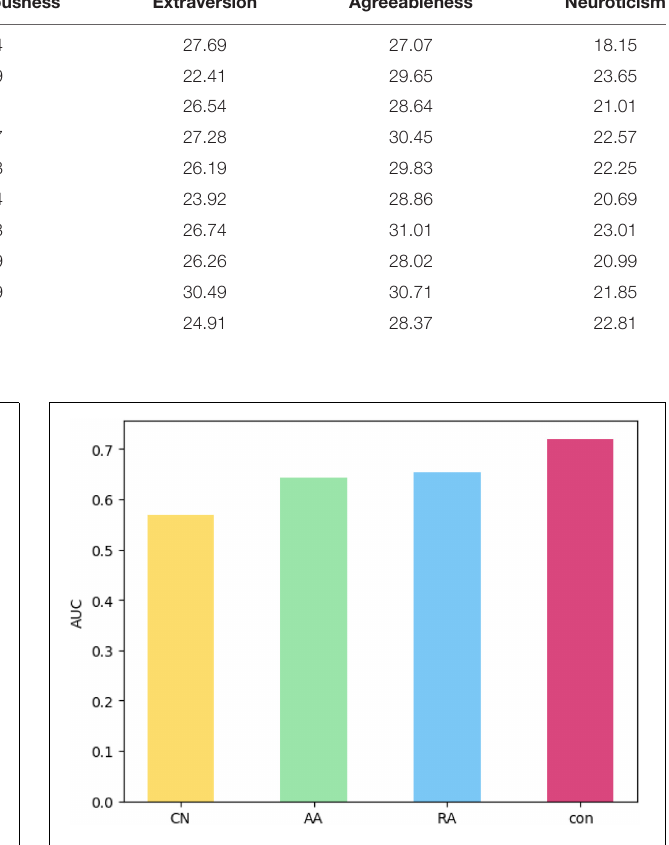
FIGURE 10 | AUC comparison of different